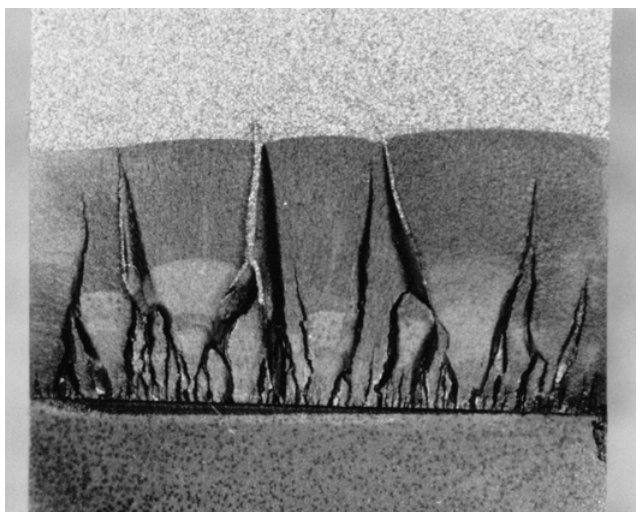
Figure 5. Fracture surface of medium strength structural steel angle notch fatigue test specimen, initial β = 60 ° .